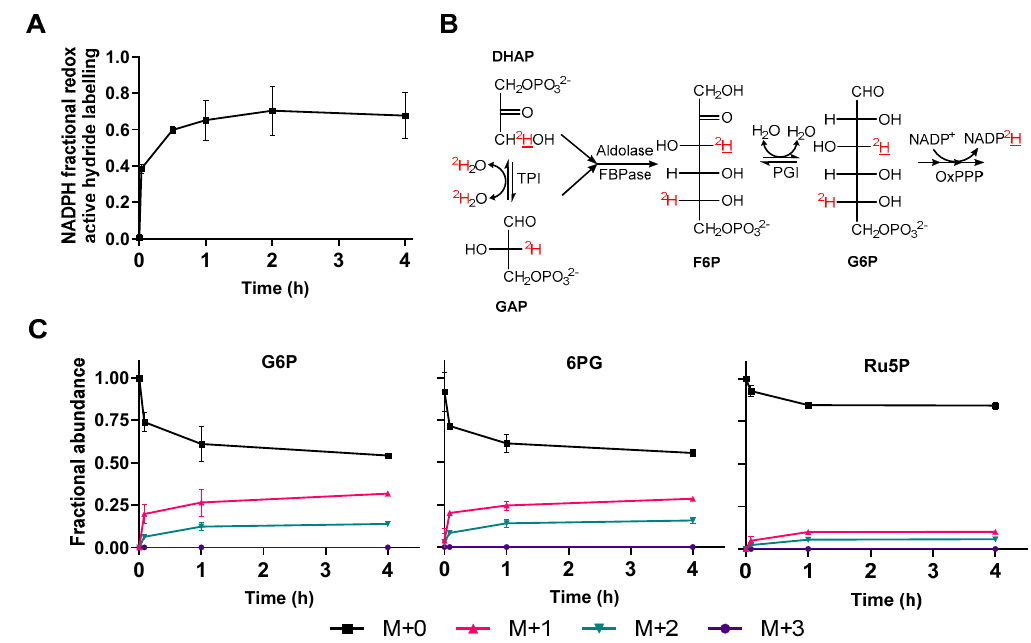
Figure 2. Deuterium labelling following transfer of Arabidopsis cells to 45% D 2 O. ( A ) NADPH redox active hydride labelling time course. Four-day-old heterotrophic Arabidopsis cells were transferred to media containing 45% D 2 O and extracted over 4 h before analysis by IPRP chromatography and Quattro Micro MS. Values are the mean ± SD, n = 3. ( B ) The route of deuterium ( 2 H) incorporation into NADPH via triose phosphate isomerase (TPI) [41]. ( C ) Mass isotopologue distributions of oxPPP intermediates after incubation of Arabidopsis cell cultures on 45% D 2 O media for up to 4 h. Samples were analysed using IE chromatography and Q-Exactive MS and corrected for natural abundance using IsoCor [43]. Values are the mean ± SD, n = 3.